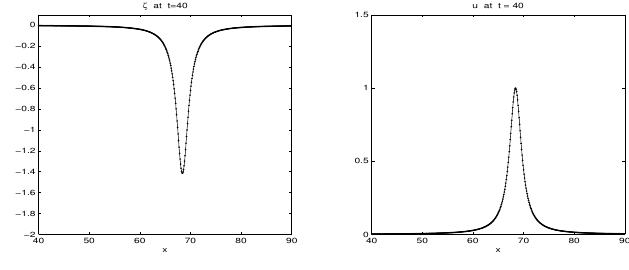
Figure 3. Zoom of Figure 2. In points: approximate solitary wave solution (5.30)–(5.31). In solid line: solution ( ζ num ,u num ) obtained with the numerical solver.